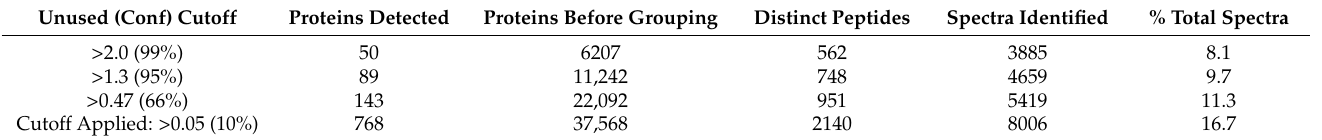
Table 2. ID Statistics (Protein-threshold) based on plant protein database.